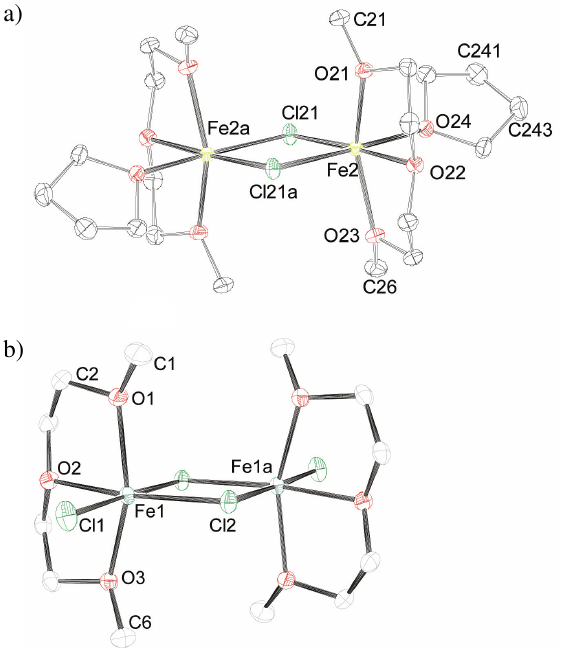
Figure 4. a) A cation of 3 , [ FeCl(diglyme)(THF) ] 2+ . b) The crystal structures of dinuclear molecular complex 4 , [ FeCl